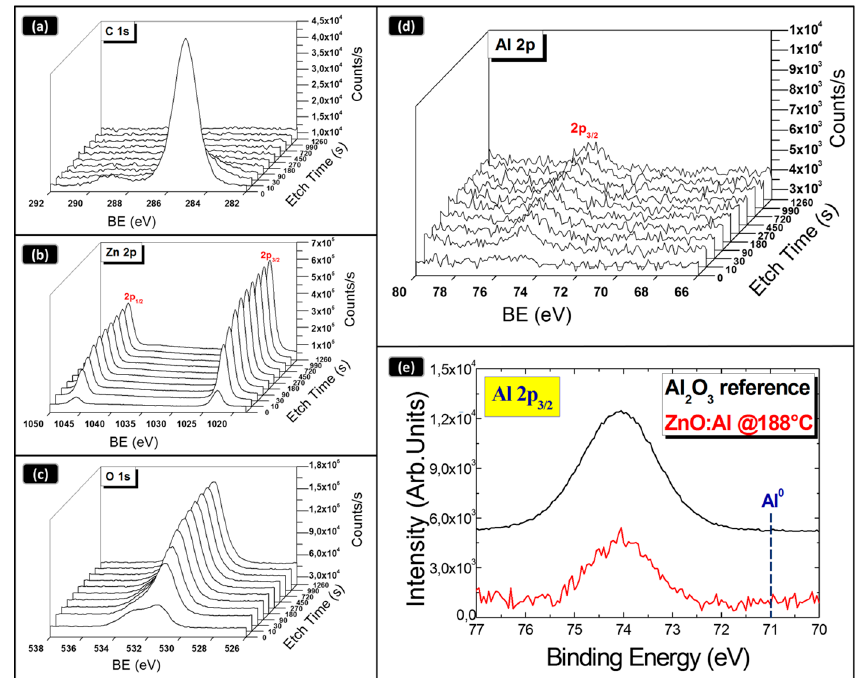
Figure 4. XPS depth profile analyses of the AZO layer deposited by co-sputtering in co-focal geometry at 188 °C: ( a ) C 1s; ( b ) O 1s; ( c ) Zn 2p; ( d ) Al 2p 3/2 spectra; and ( e ) Al 2p 3/2 spectrum taken on the AZO layer and on a reference Al 2 O 3 material. Al 0 is the expected peak position for a metallic layer.